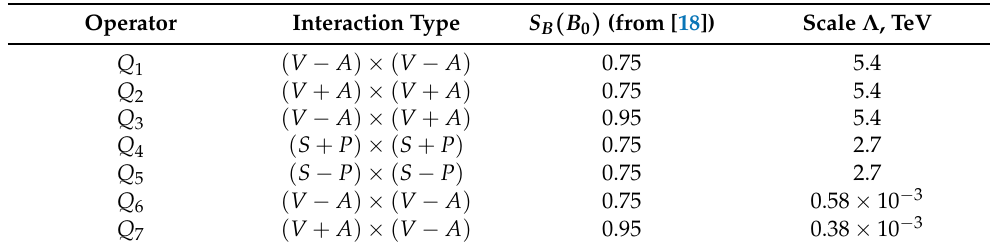
Table 1. Constraints on the energy scales probed by different ∆ L = 2 operators of Equations (6) and (7) in MACS experiment (from